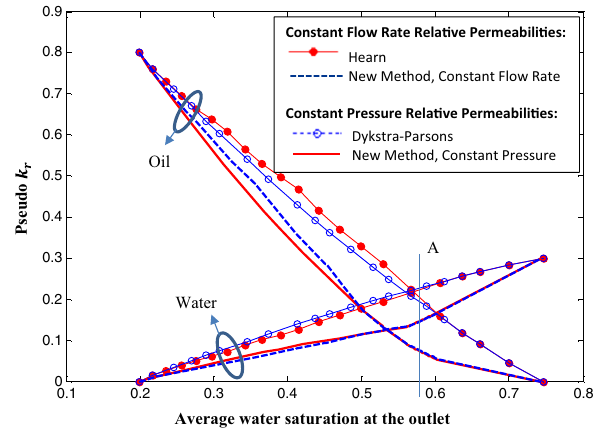
Fig. 3 Pseudorelative permeability curves